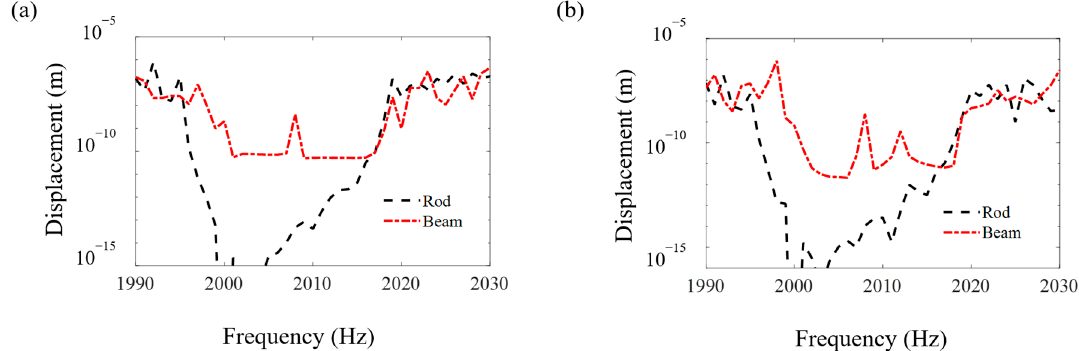
Figure 10. The FRF curves of the metamaterial plates with the beam cores and rod cores near the third axial vibration band-gaps in the z direction of the beams at points A and B of the cover plates. ( a ) Point A and ( b ) point B .